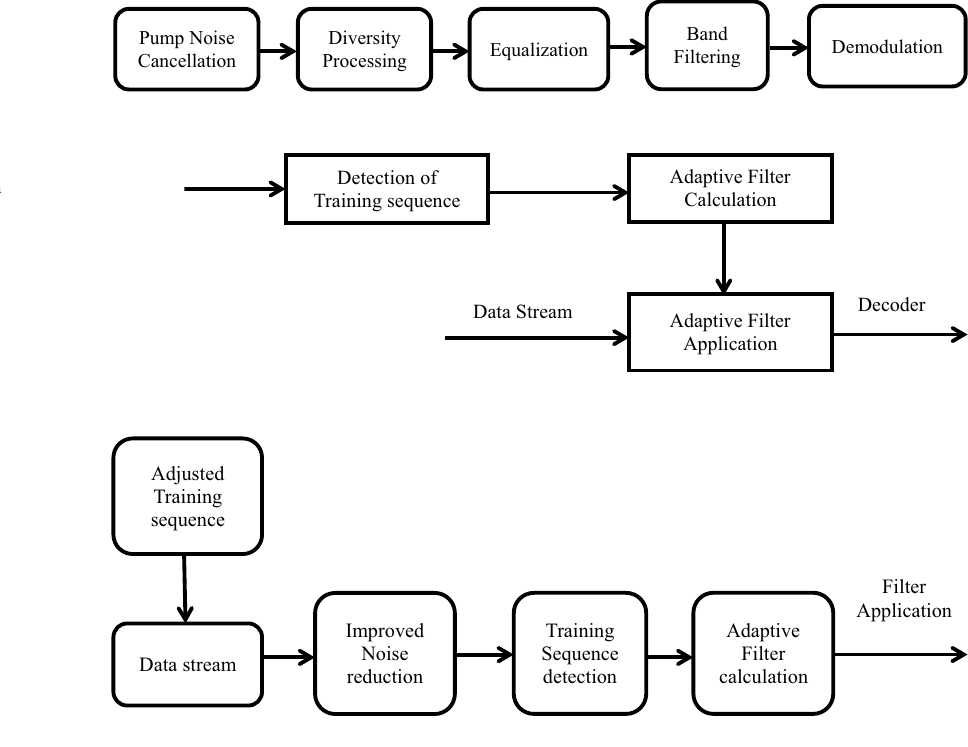
Fig. 2 Signal processing of new MPT system (Klotz et al. 2008c)